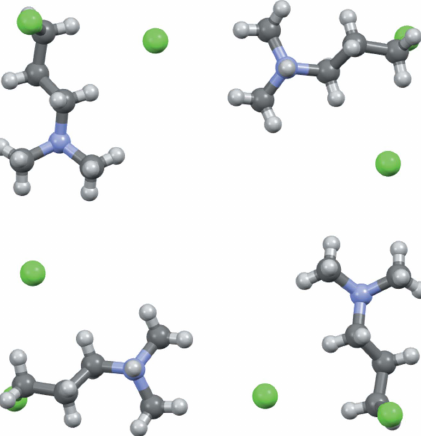
Figure 5 Ball-and-stick diagram of the square structural motif found in the layer depicted in Fig. 3.